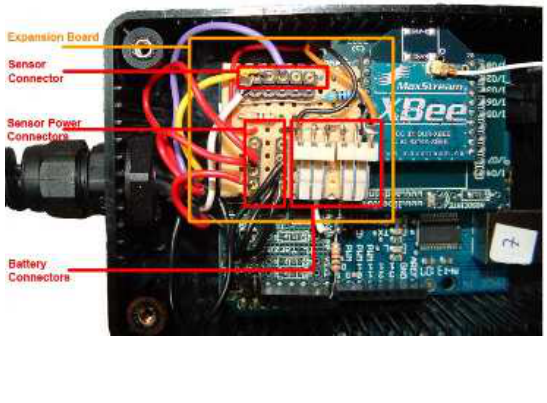
Figure 3. Photograph SquidBee mote with expansion